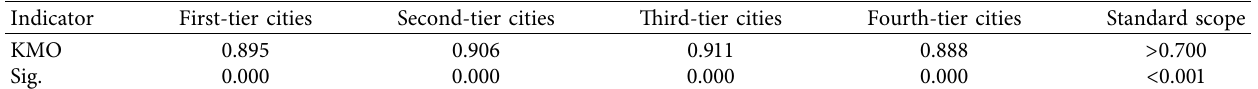
Table 3: KMO and Bartlett’s test